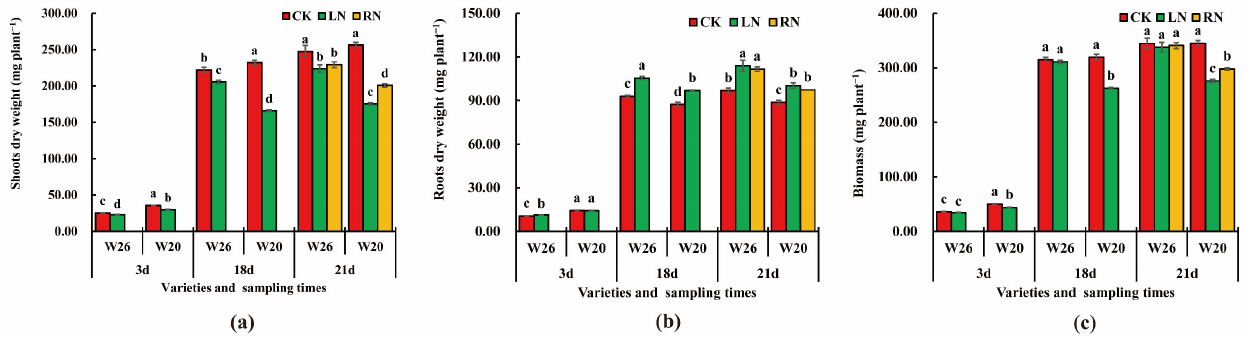
Figure 2. Barley dry weight and biomass at the three time points under different nitrogen treatments. CK represents normal nitrogen, LN represents low nitrogen, and RN represents nitrogen resupply after low nitrogen stress. ( a ) Shoot dry weight; ( b ) root dry weight; ( c ) biomass. The small letters represent the significant difference at the same time ( p <